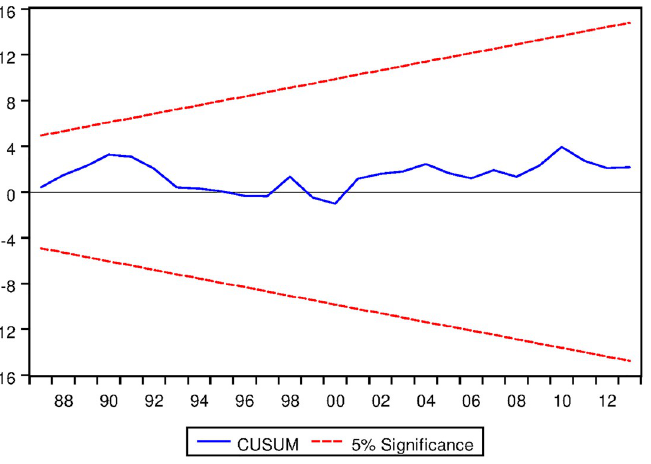
Fig 21. Stability diagnostic of cointegrating relationship for Korean data with linear trend as fixed regressor under proposed framework.